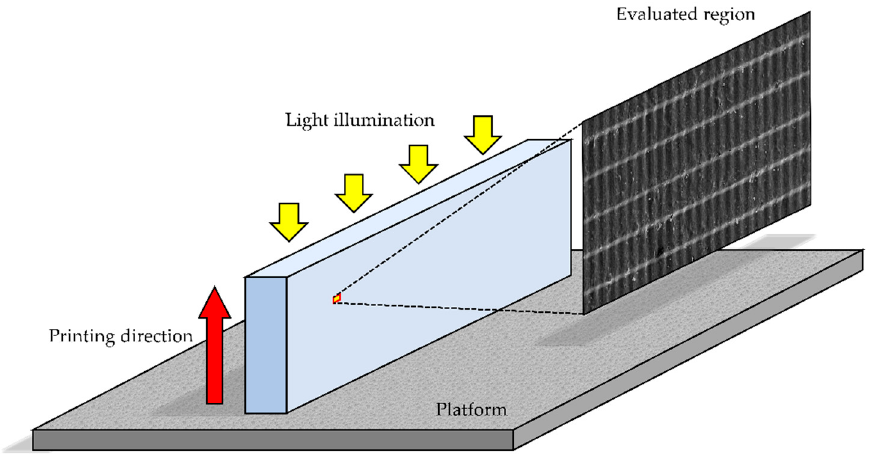
Figure 1. The printing direction (red arrow), direction of light illumination (yellow arrows) and evaluated region for Vickers hardness number (VHN) and three-dimensional (3D) microlayer structure.